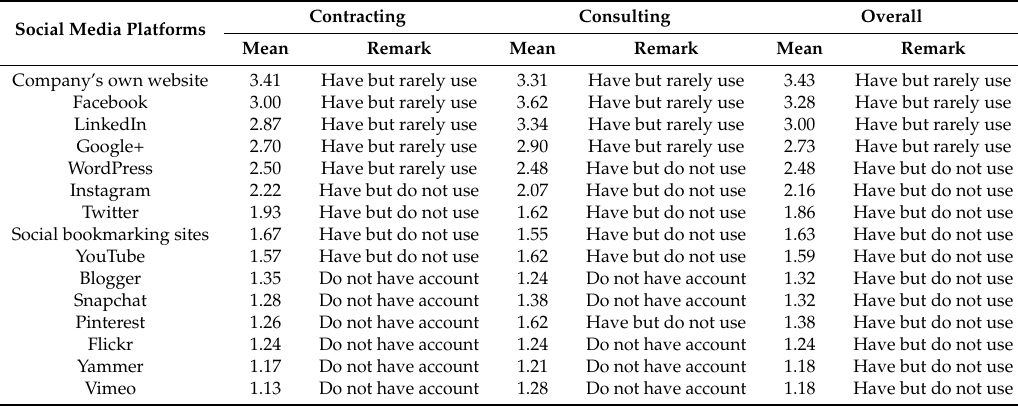
Table 4. Presence of construction organizations on social media